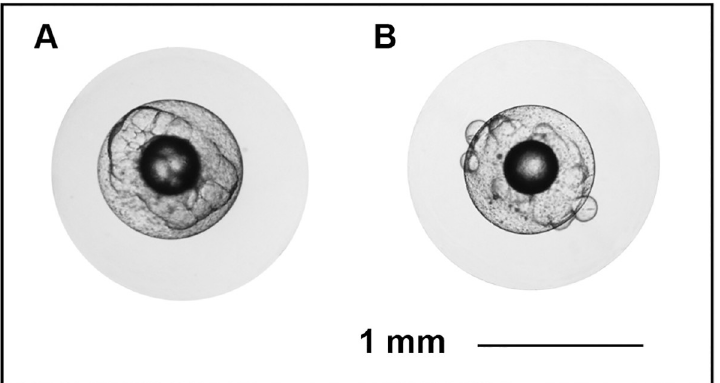
Fig 2. Examples of normal development and cleavage abnormalities in European eel, Anguilla anguilla embryos. Eggs with (A) normal development and (B) occurrence of cleavage abnormalities at 4 hours post fertilization. Scale bar represents 1 mm.